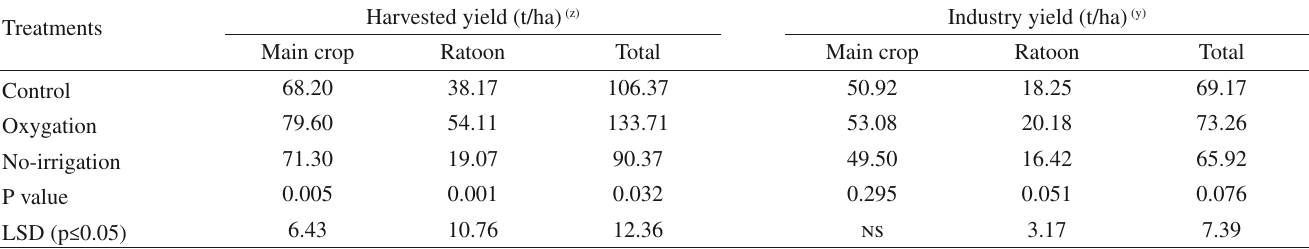
Table 8 - Pineapple fruit yield from the sample area (harvested yield) and industry marketable harvest (industry yield) for the main and ratoon crops